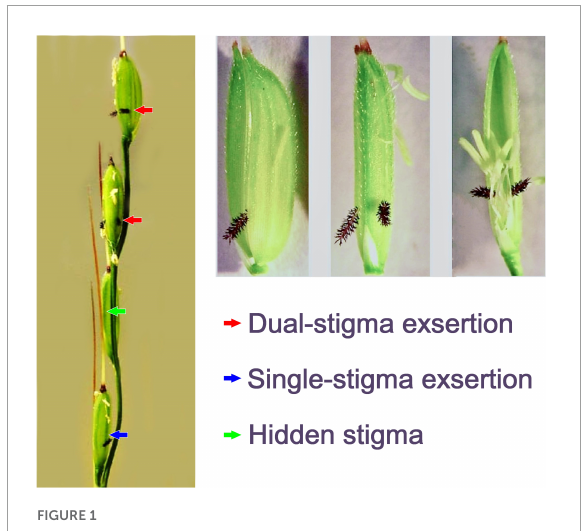
FIGURE1 Illustration of stigma exsertion in rice [adapted from Yan et al. (2009) and Zhou et al. (2017) with some